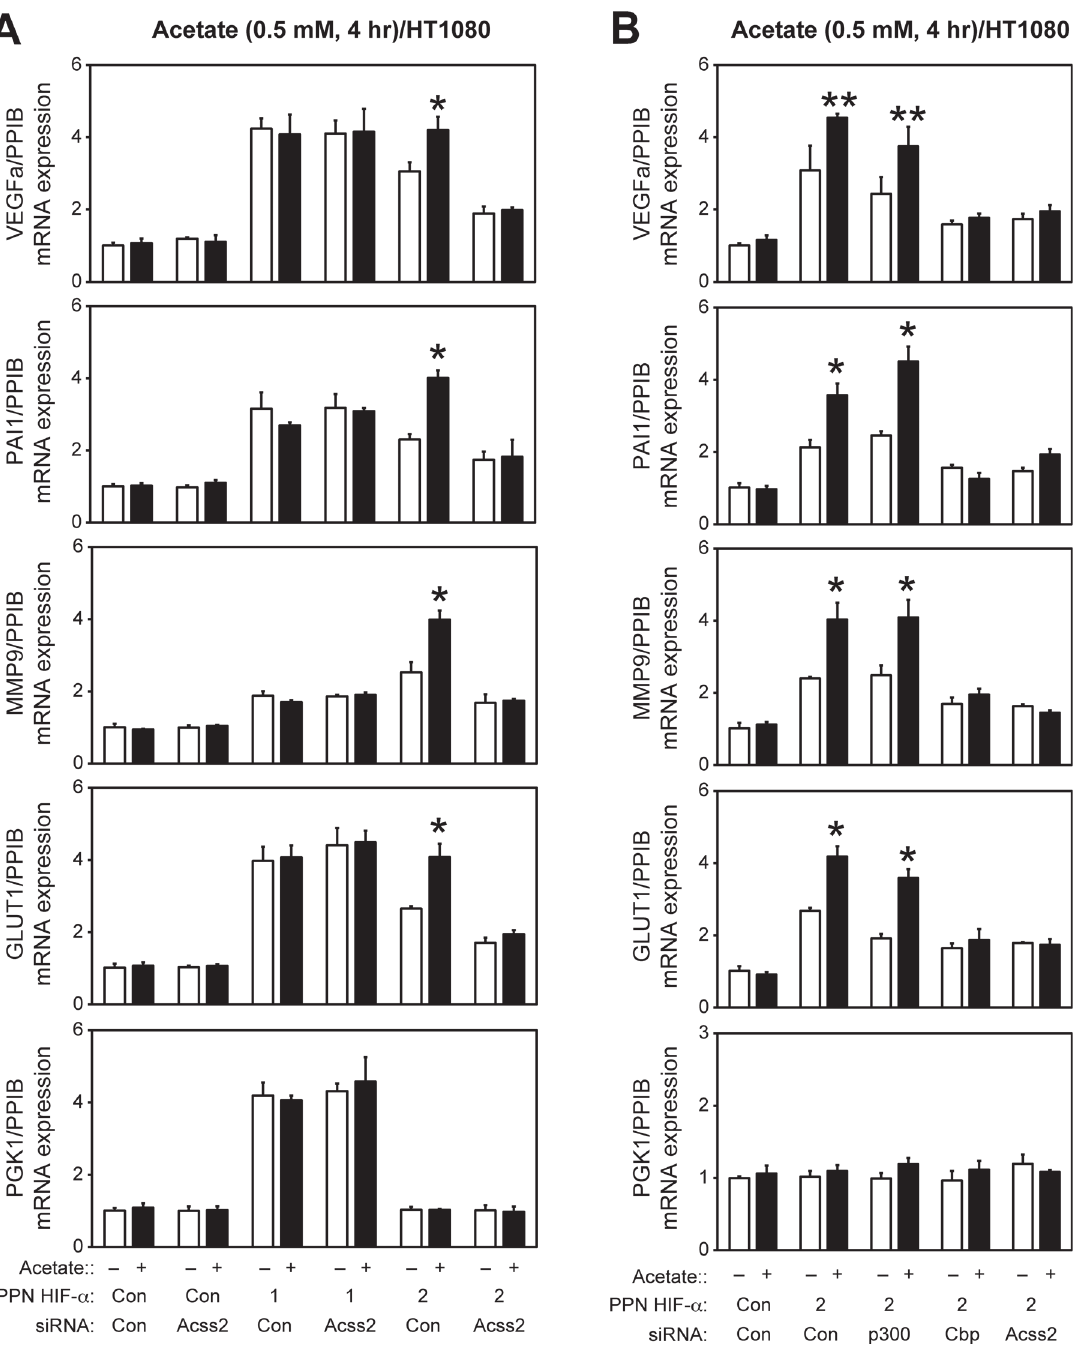
Fig 5. ACSS2/CBP mediate acetate augmentation of HIF-2 signaling. HIF target genes induced in (A) HT1080 cells expressing no ectopic HIF (control), oxygen-insensitive (PPN) HIF-1 α , or PPN HIF-2 α following control or ACSS2 knockdown, and treated with vehicle or acetate, or in (B) HT1080 cells expressing PPN HIF-2 α following control, p300, CBP, or ACSS2 knockdown, and treated with vehicle or acetate. Comparison by one-tailed t-test between vehicle (empty bars) and acetate treatment (filled bars) with significant increases compared to vehicle treatment indicated (single pool of triplicate biological replicates/manipulation; triplicate measurements/pool; mean/SD; * , P < 0.05; ** , P < 0.10).